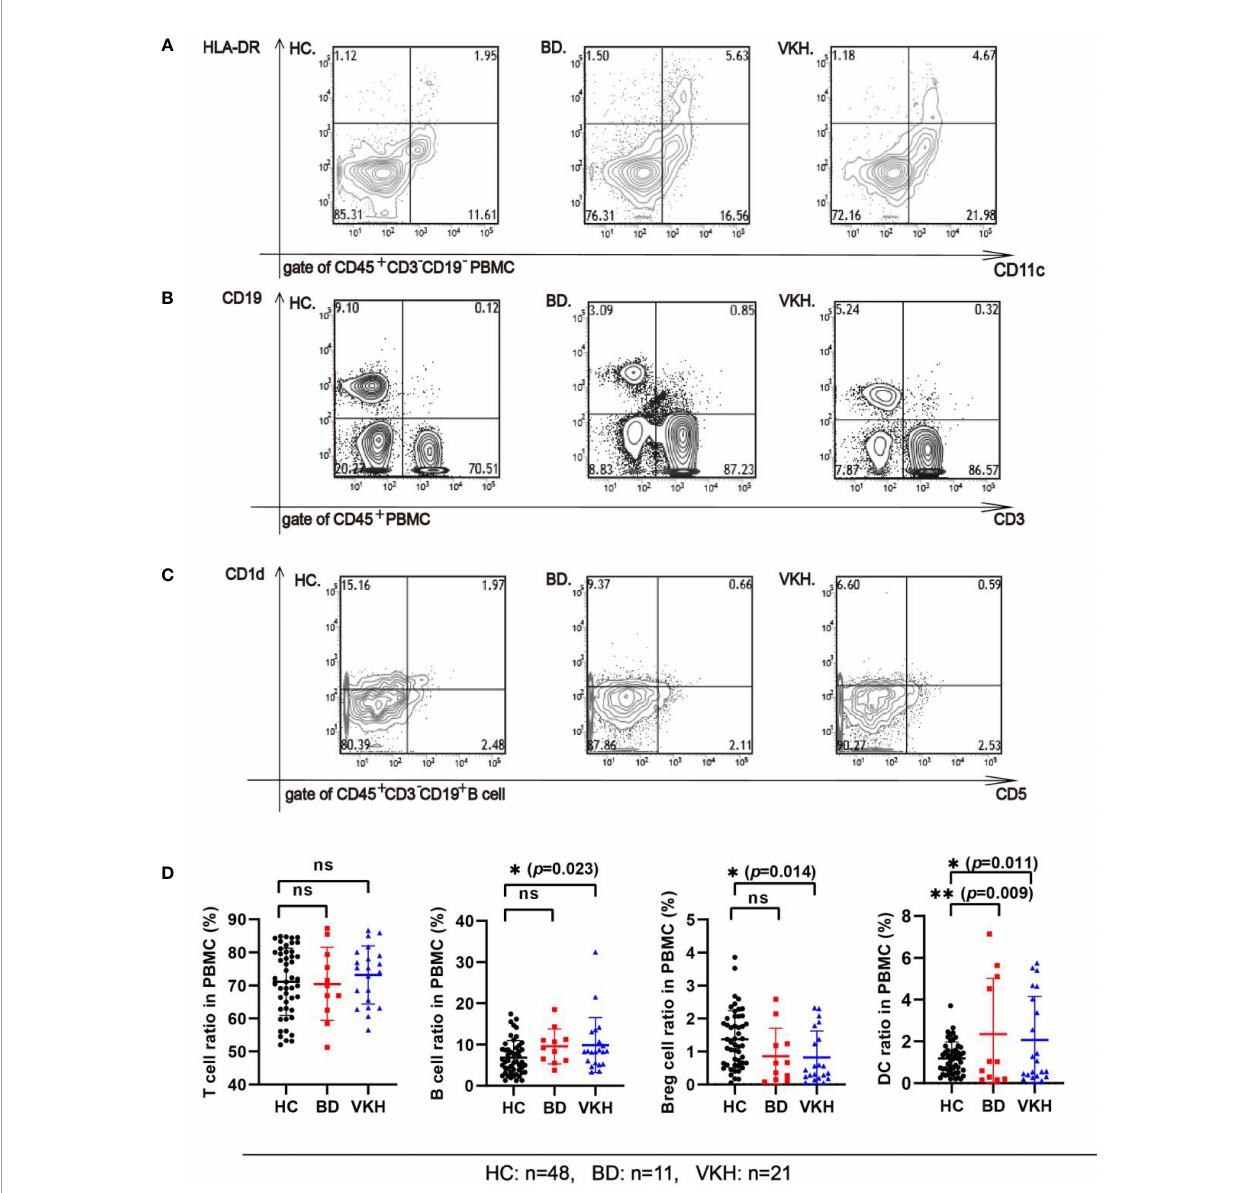
FIGURE 2 | Comparing the subsets of immune cells from the PBMC of the healthy control group and patients. (A) The percentage of DC cells in the PBMC of the healthy control group and patients (gate of CD45 + cells). Representative fl ow cytometry plot shows the percentage of CD45 + CD3 − CD19 − CD56 − CD14 − CD11c + HLA-DR + DC cells in the PBMC of the healthy control group (HC), in BD patient, and in VKH patient. (B) The percentage of T and B cells in the PBMC of the healthy control group and patients (gate of CD45 + cells). Representative fl ow cytometry plot shows the percentage of CD45 + CD3 + T cells, CD45 + CD3 − CD19 + B cells in the PBMC of HC, in BD patient, and in VKH patient. (C) The percentage of Breg cells (CD45 + CD3 + CD19 + CD1d + CD5 + B cells) in the PBMC between the healthy control group and patients (gate of CD45 + CD3 + CD19 + B cells). Representative fl ow cytometry plot shows the percentage of CD45 + CD3 − CD19 + CD1d + CD5 + Breg cells in the PBMC of HC, BD patient, and in VKH patient. (D) The percentage of T cell, B cell, Breg cell and DC in PBMC of healthy control group and patients (* p <0.05; ** p <0.01; ns, p